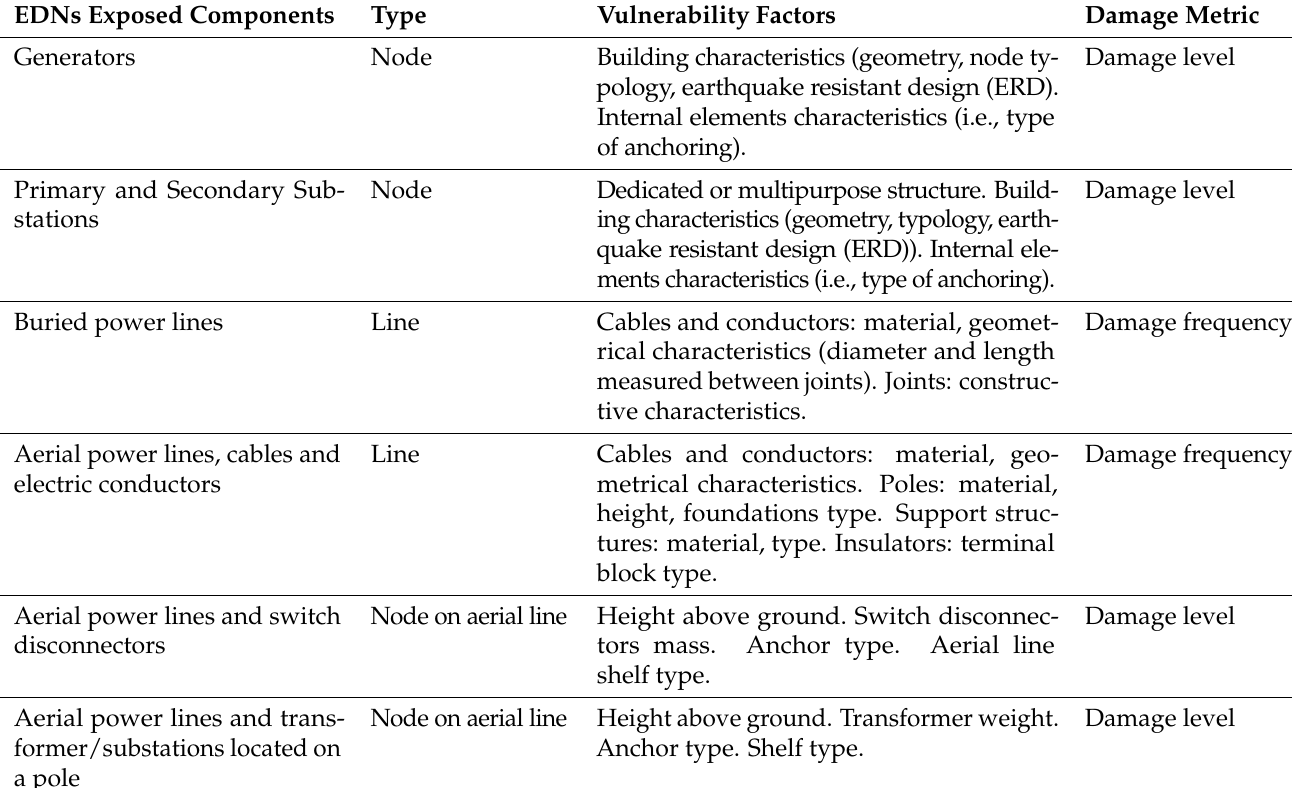
Table 1. Proposed taxonomy for assessing vulnerability of EDNs